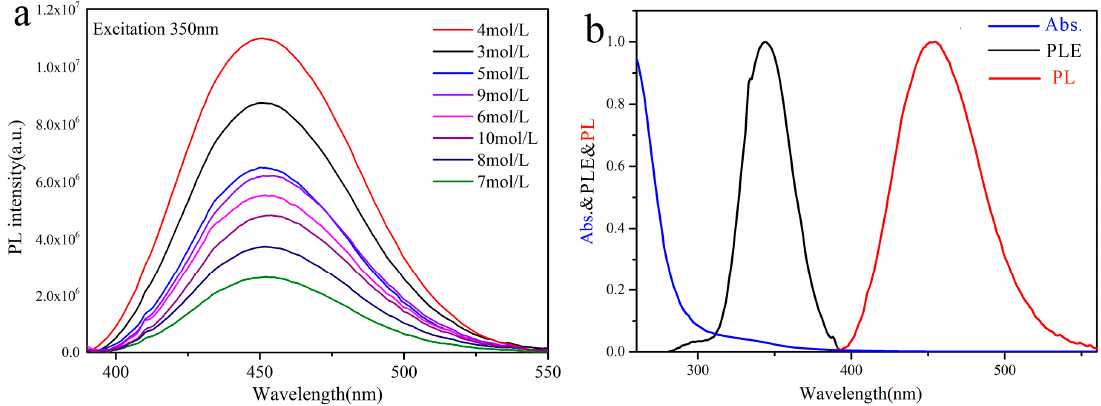
Figure 6. ( a ) The PL spectra of the Cs 2 SnCl 6 crystals in Figure 3. ( b ) The absorption, PL and PLE spectra of the Cs 2 SnCl 6 crystals in Figure 3g.